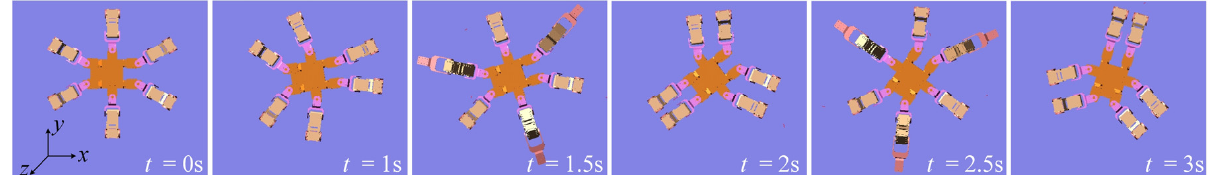
Figure 10. The simulation screenshots of the self ‐ turning gait.